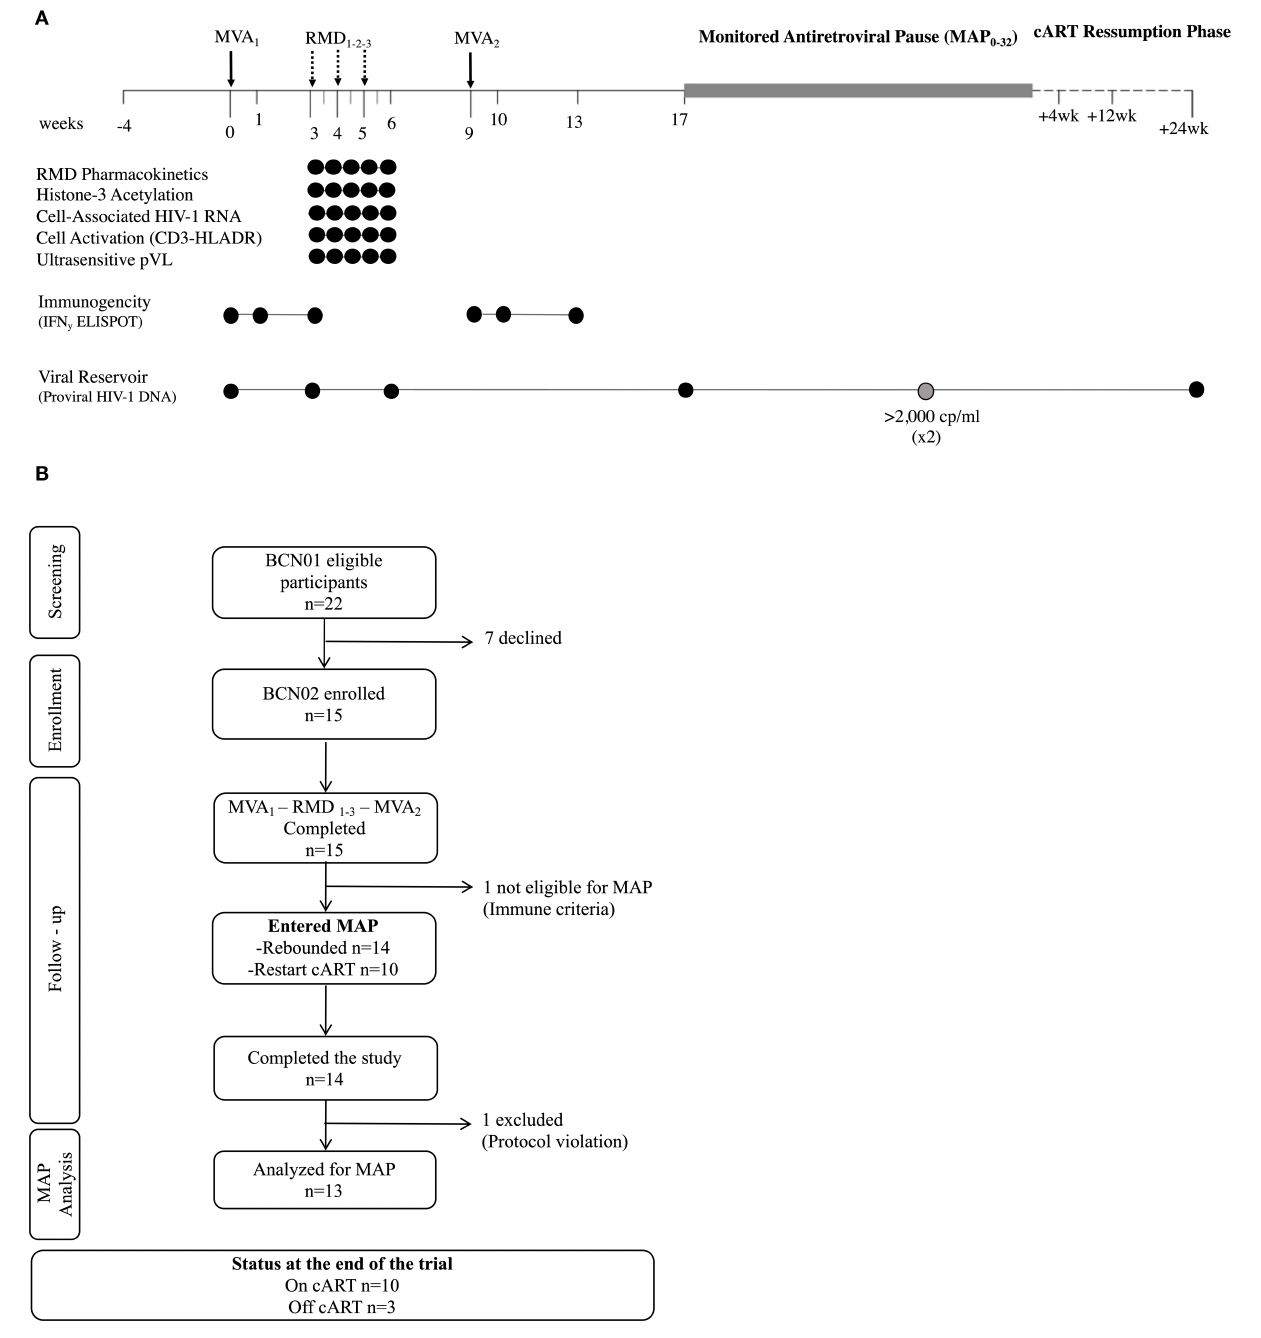
FIGURE 1 | Trial design. (A) Schematic study design. (B) Consolidated Standards of Reporting Trials (CONSORT) flow diagram for the trial. *Viral rebound during MAP was defined as pVL > 20 copies/ml and # criteria for ART resumption included pVL over 2,000 copies/ml in two consecutive determinations, CD4 + cell counts decrease over 50% and/or below 500 cells/mm 3 and/or development of clinical symptoms suggestive of an acute retroviral syndrome. MVA, MVA.HIVconsv vaccine; RMD, romidepsin; MAP, monitored antiretroviral pause; ART, antiretroviral therapy; pVL, plasma HIV-1 viral load.